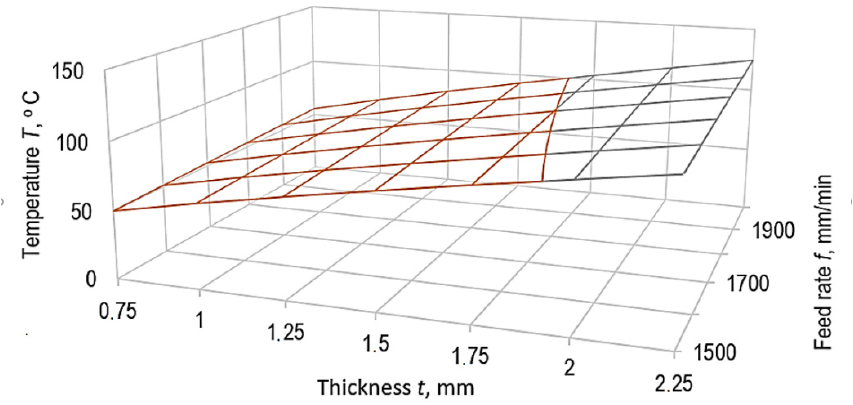
Figure 8. The influence exerted by the workpiece thickness t and feed rate f on the temperature of the rotating forming tool when processing in the air ( s d = 0.5 mm).